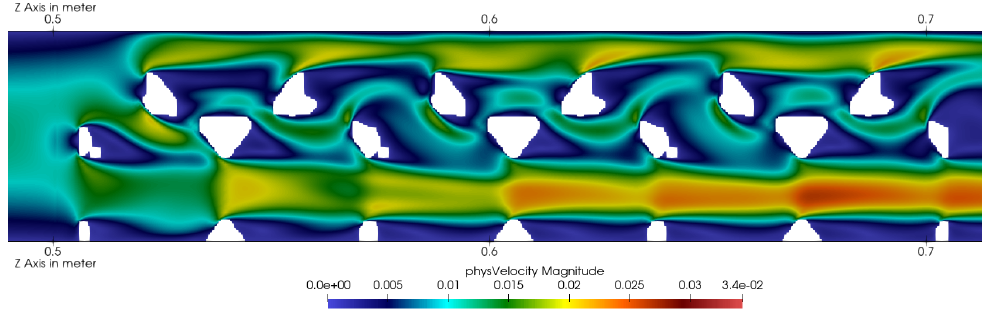
Figure 8. Local velocities for an inflow of 0.01m/s. White regions are the sponge